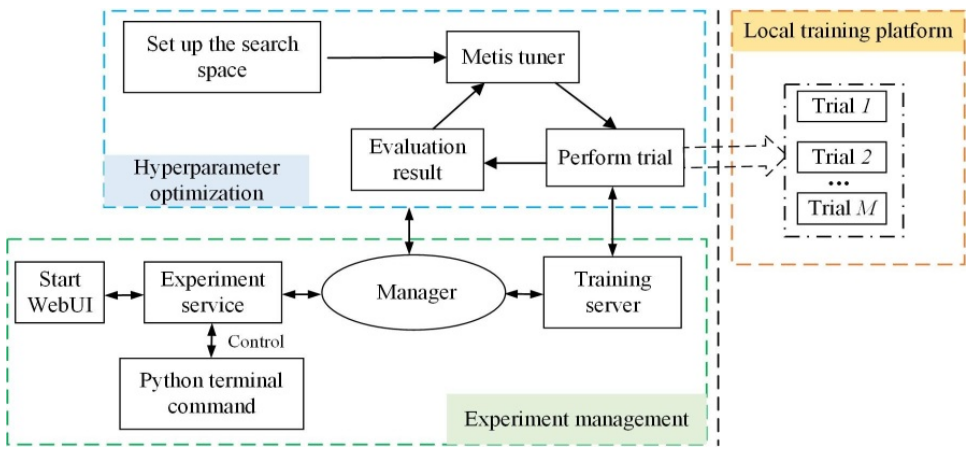
Figure 3. AutoML-based MASAC hyperparameter optimization.